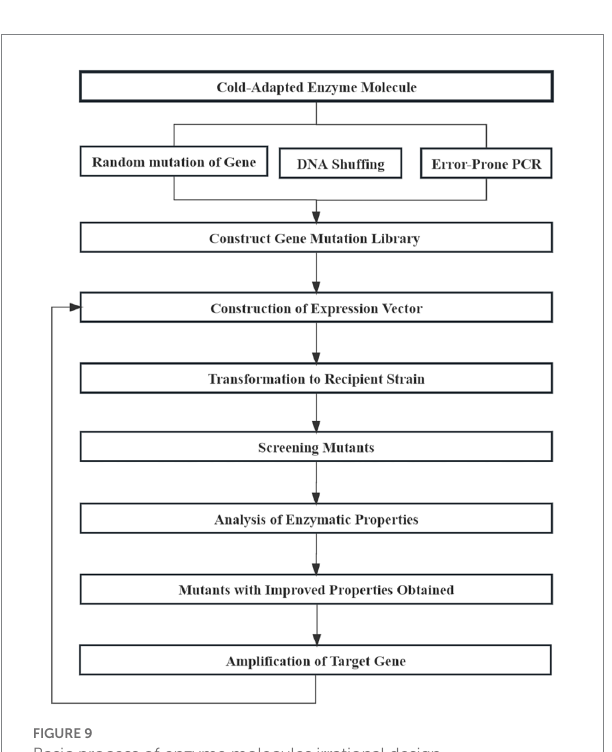
FIGURE 9 Basic process of enzyme molecules irrational